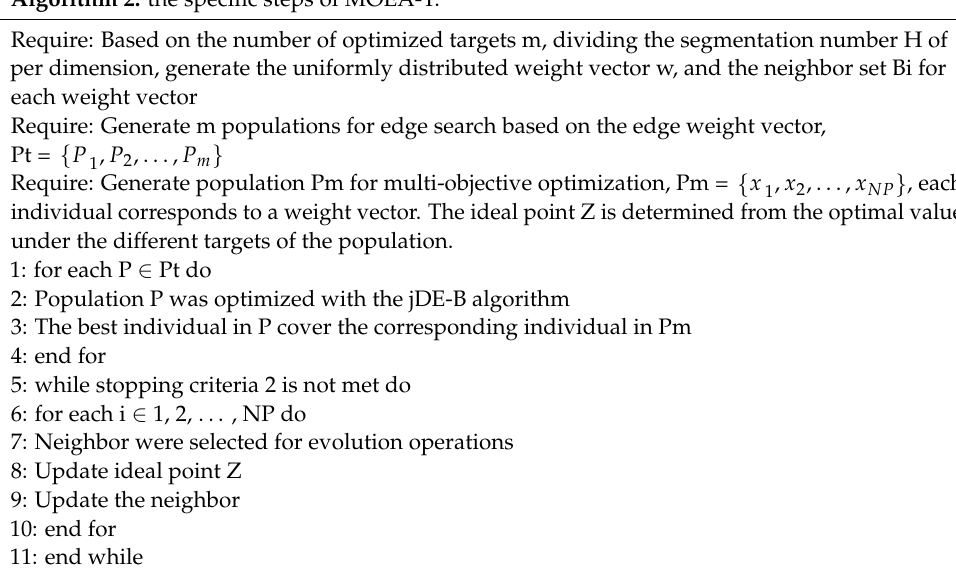
Algorithm 2. the specific steps of